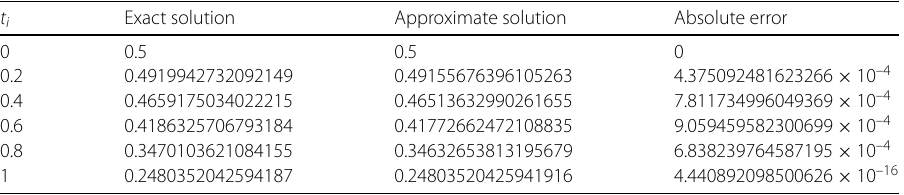
Table 4 The absolute errors of approximating y 2, α for (1,1)-system at various t and α = 0.5